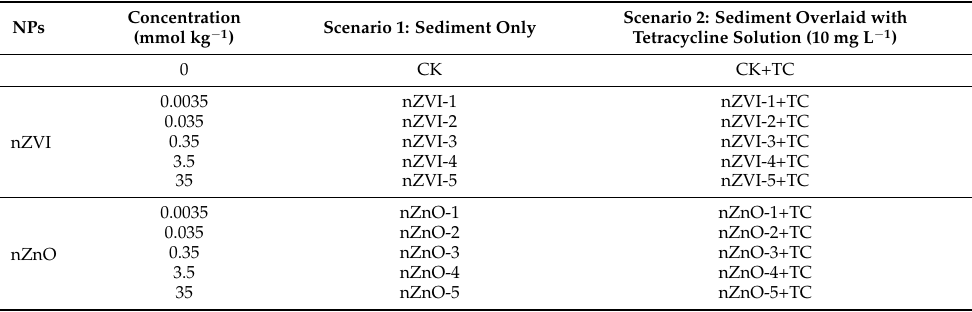
Table 1. Experimental design of NP addition and the abbreviation used in this study.